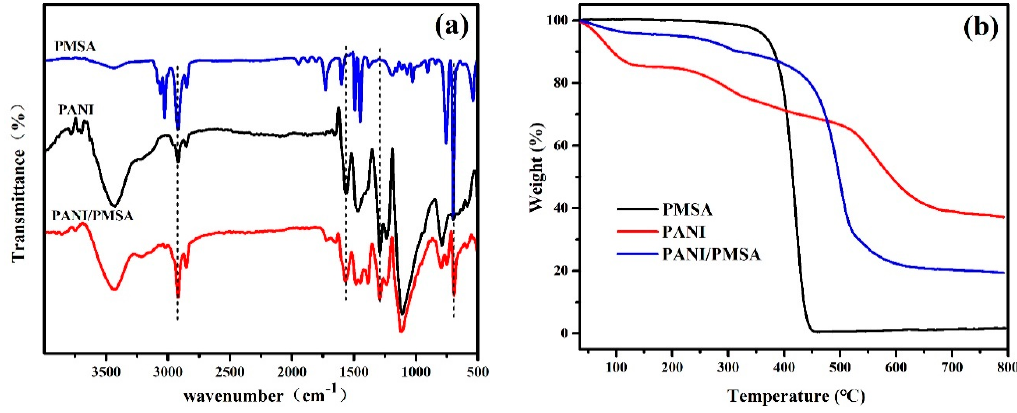
Figure 2. Fourier-transform infrared (FT-IR) curves ( a ) and thermogravimetric analysis (TGA) curves ( b ) for PANI, PSMA, and PANI/PSMA.